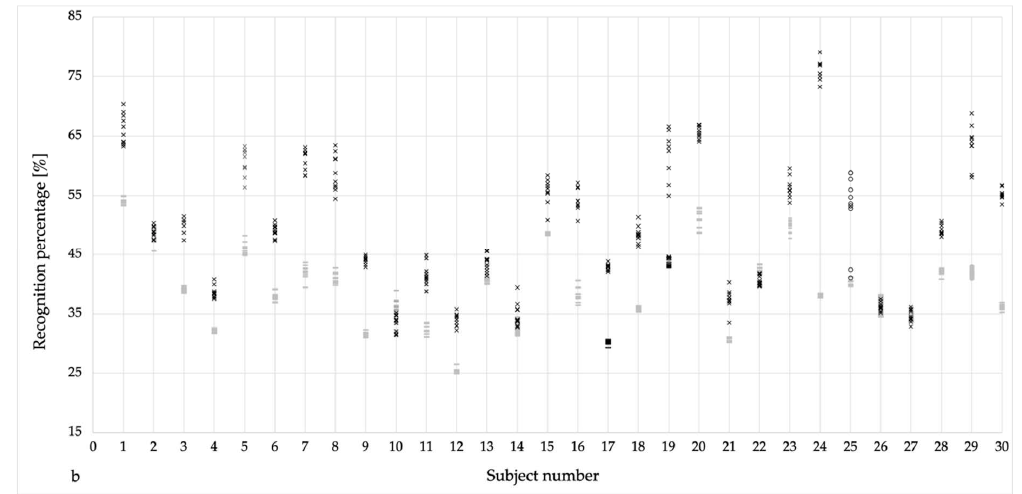
Figure 3. Recognition percentages presenting same-subject values (green dots in ( a ) & black crosses in ( b )) and di ff erent-subject (worst-case) values (grey dashes in ( a , b )). The outcomes based on equation (3) concerning the probability of detecting a false positive assignment, when checking for an individual running pattern, are, on average, below 1% with a maximal false detection rate of approximately 9% (subject 11). Figure 4 shows a complete overview of all participants.